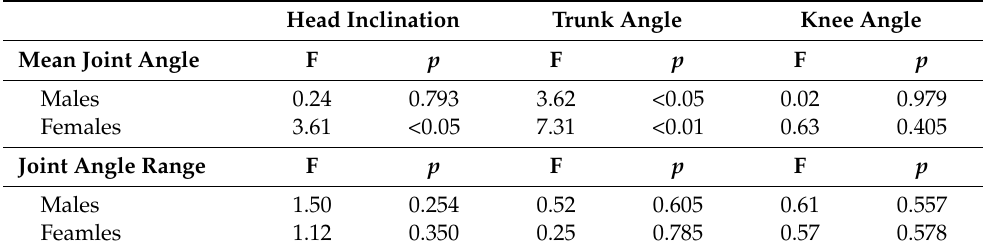
Table 3. One-way ANOVA results for chair type in relation to joint angle for each gender.